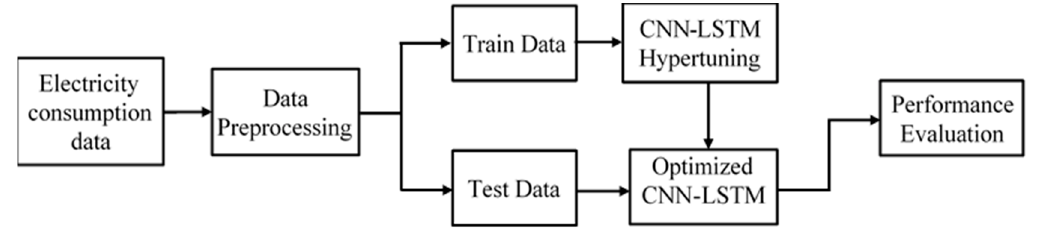
Figure 1. Block diagram of the proposed electricity theft detection system.